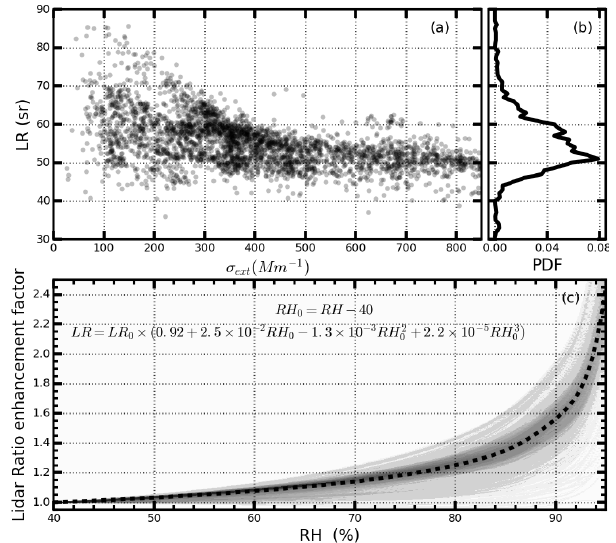
Figure 2. LR distribution and LR enhancement factor during the Hachi campaign. (a) LR distribution under different polluted con- ditions. (b) Probability distribution function (PDF) of the LR. (c) Enhancement factor of the LR. The dashed line is the mean fit LR enhancement